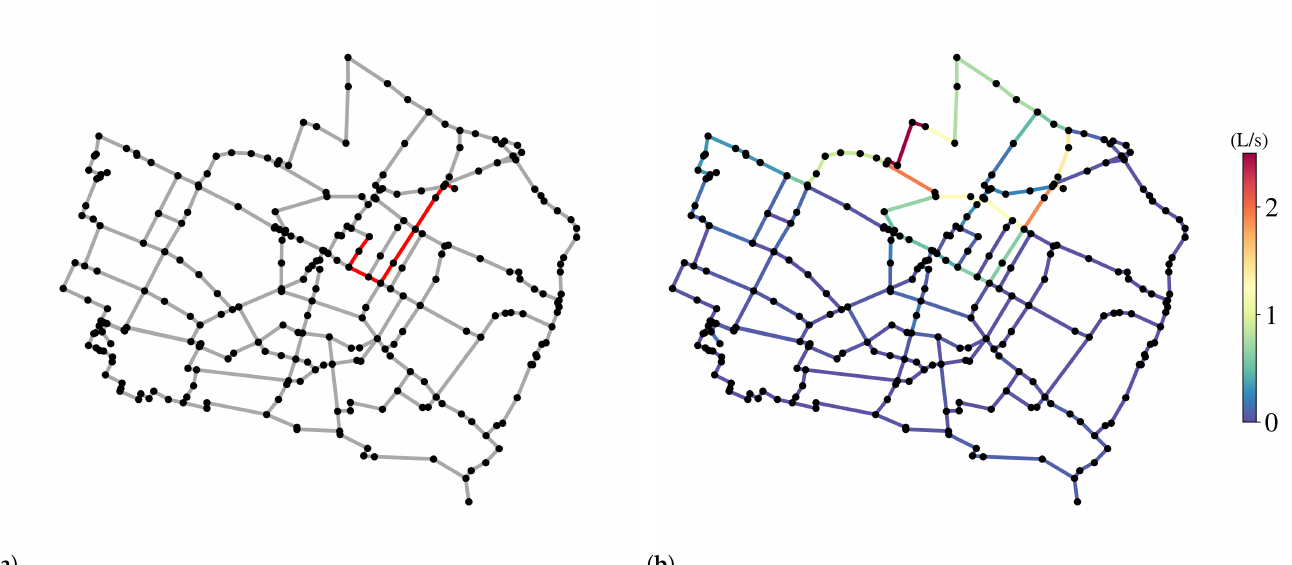
Figure 9. Network behavior flow: ( a ) Shortest path—reservoir 269 to node 104 and ( b ) flow differences—leakage node